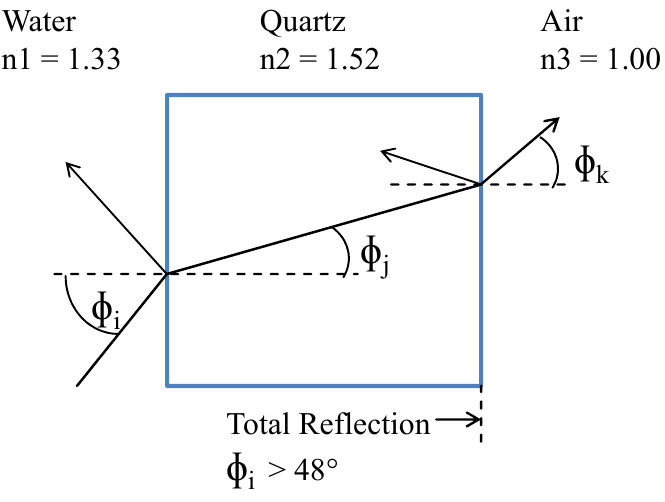
Figure 5. Optical reflection characteristics at water-quartz and quartz-air